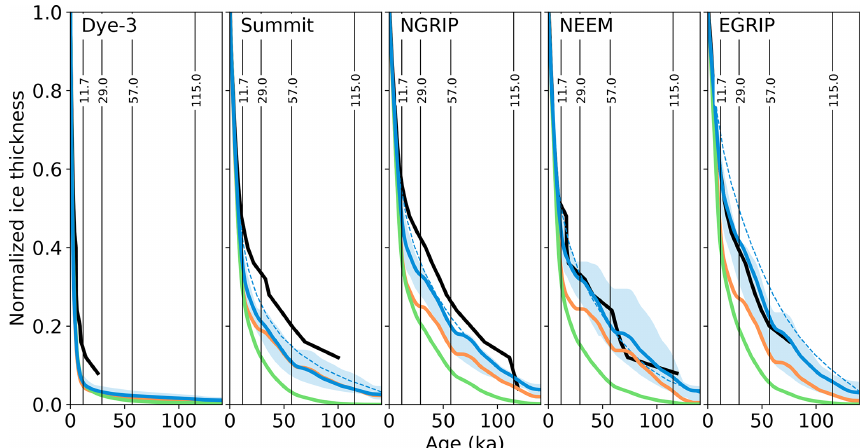
Figure 11. Age profiles of selected ice core locations (see Fig. 5 for map). The curves show radiostratigraphy data (black), BEST ice (green), BEST all (blue), and the Eulerian age tracer of BEST all (dashed blue). The orange curve shows the simulation that produces optimal results for all evaluation surfaces but based on the Eulerian age tracer. The shaded areas are the 10% best simulations in the combined RMSE, as in Fig.